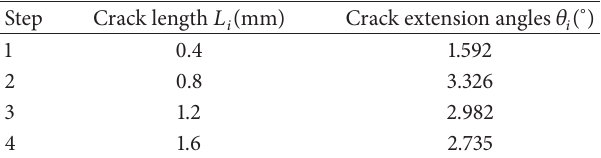
Table 3: Crack lengths and extension